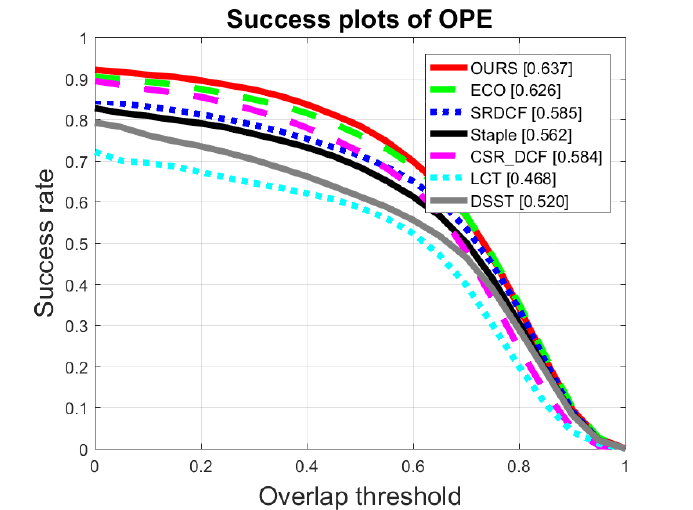
Figure 7. Comparison of Success plots with 7 trackers on